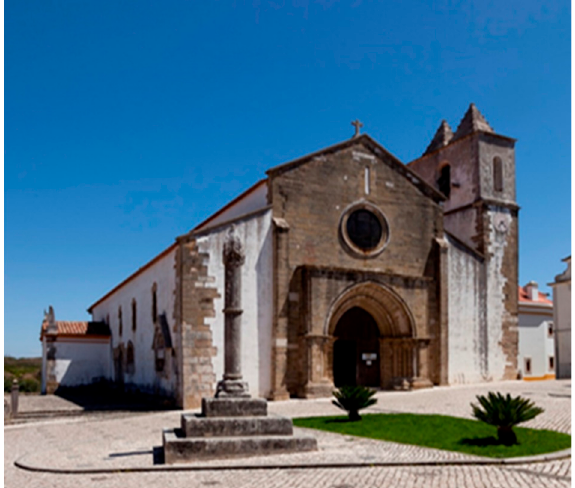
Figure 2. St. Leonard Church: View of the main façade (West) of the sandstone national monument in Atouguia da Baleia with its Gothic vault.